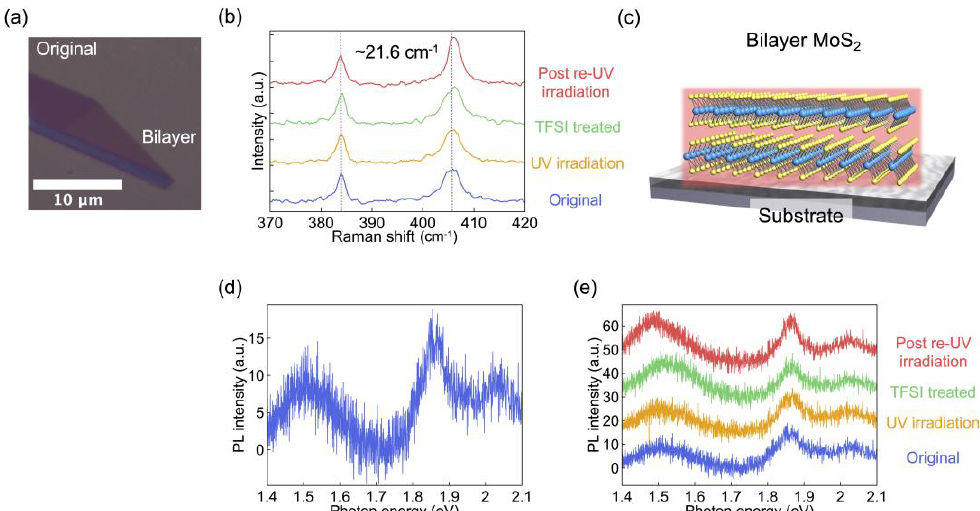
Figure 6. ( a ) Optical microscope image of the sample exfoliated without pressing with the weight. ( b ) Raman spectra for the as-exfoliated (original, blue), UV-irradiated (orange), TFSI-treated (green), and re-UV-irradiated (red) bilayer MoS 2 . The peak separation between E 2g and A 1g is about 21.6 cm −1 . ( c ) The plausible situation of the bilayer MoS 2 from the Raman spectra in Figure 6b. This bilayer is a conventional flake. ( d , e ) PL spectra for the bilayer MoS 2 corresponds to Figure 6b; the original is shown in Figure 6d.